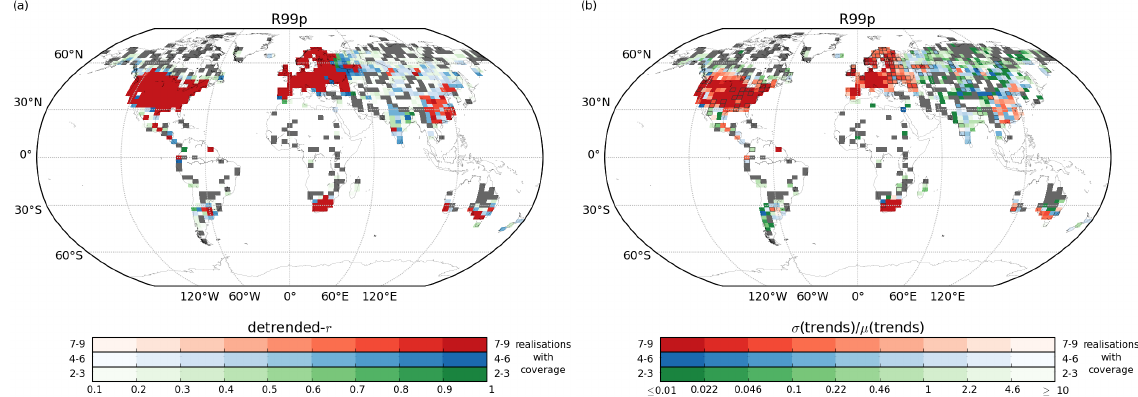
Figure 6. (a) The mean correlation coefficient of the detrended time series, r with HadEX2 for all the grid boxes and (b) the standard deviation of the trends divided by the mean trend ( σ/µ ) calculated for the period 1951 to 2010 for R99p. For further details see Fig. 5.